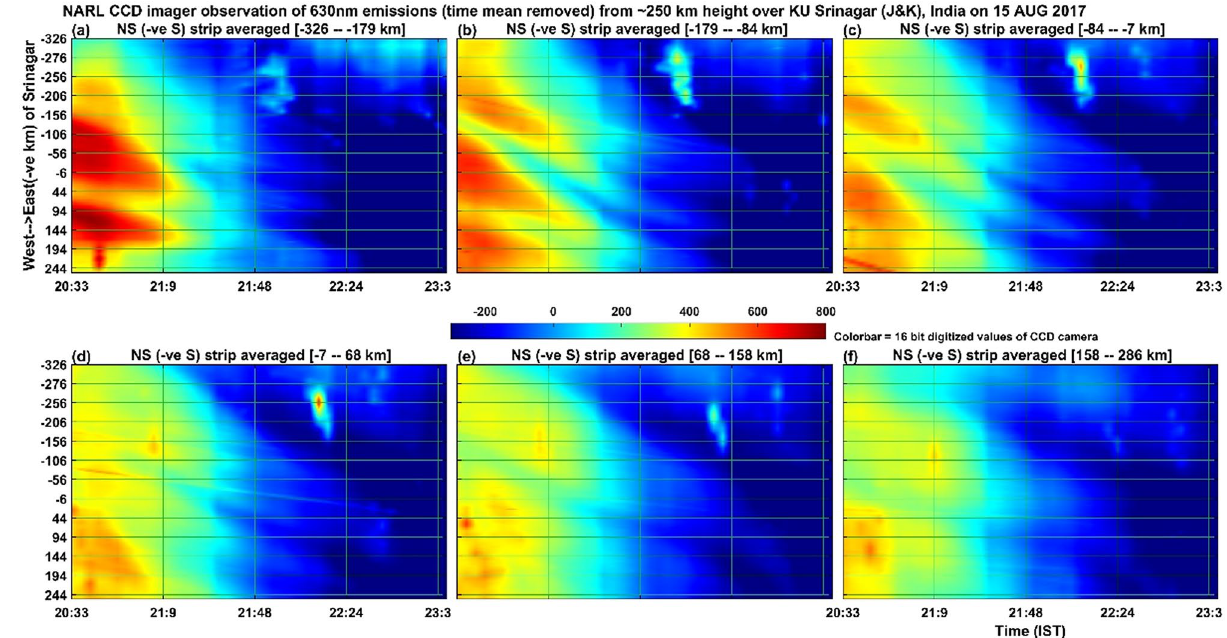
values correspond to South of the imager location, which corresponds to the values mentioned within strip averaged